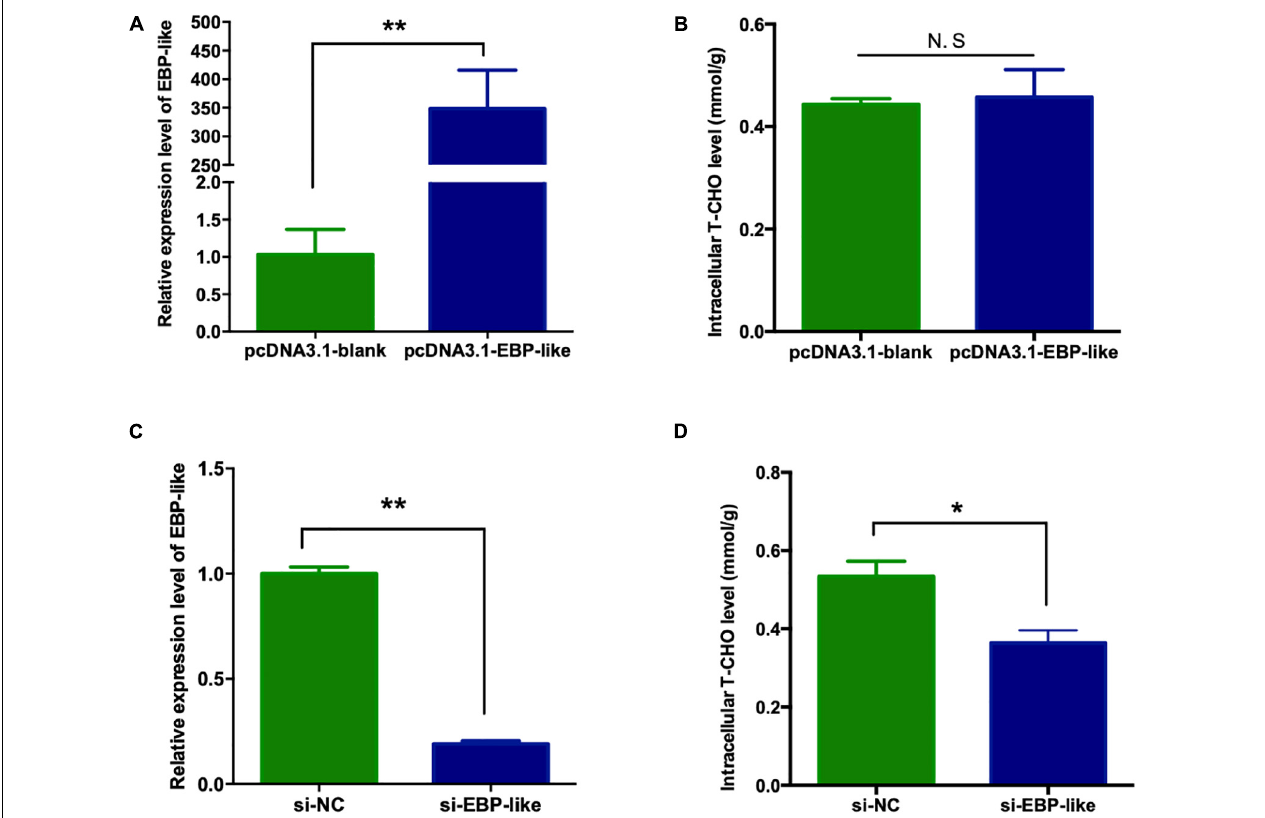
FIGURE 6 | Effect of EBP-like gene on intracellular cholesterol level. (A) Expression level of EBP-like gene after transfection with pcDNA3.1-EBP-like vector. (B) Effect of EBP-like overexpression on liver intracellular cholesterol level. (C) Expression level of EBP-like gene after transfection with si-EBP-like vector. (D) Effect of EBP-like interference on liver intracellular cholesterol level. All data are presented as mean ± SD ( n = 4–6). * P < 0.05, ** P < 0.01. N.S represents for no significant difference ( P > 0.05).